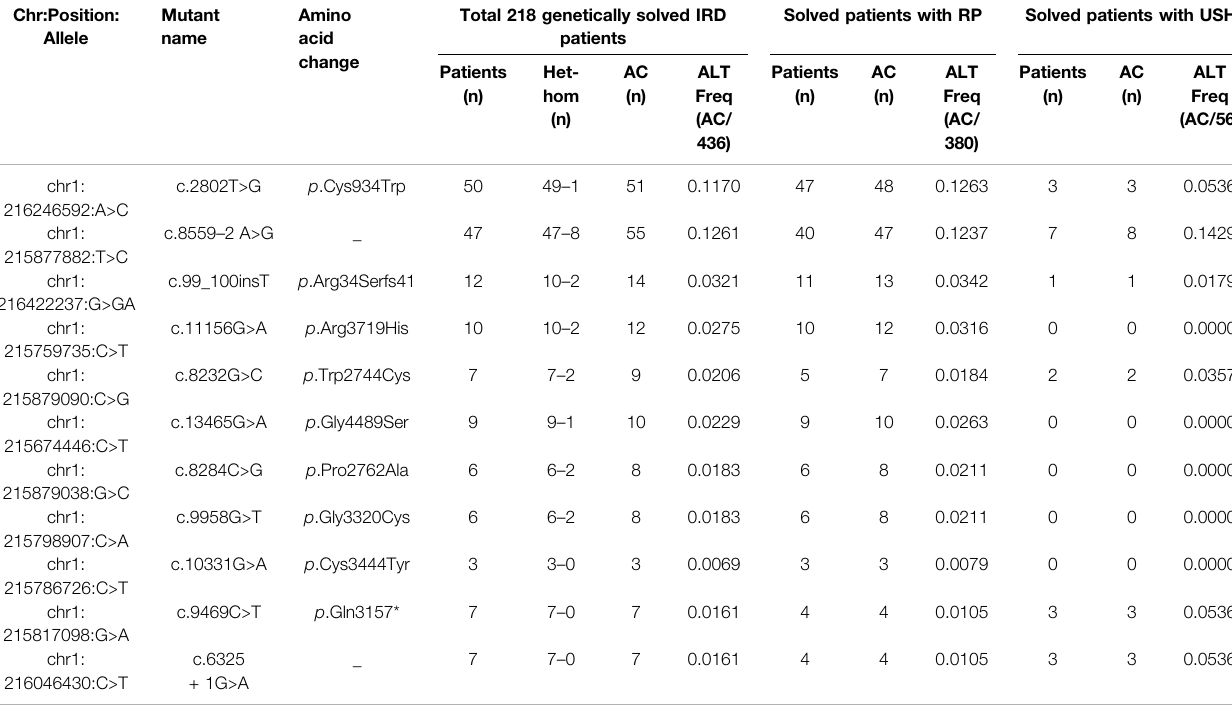
TABLE 3 | Top eleven frequent mutations in 218 genetically solved patients with USH2A-IRD, including 190 patients with RP and 28 patients with USH. Chr:Position: Mutant Allele